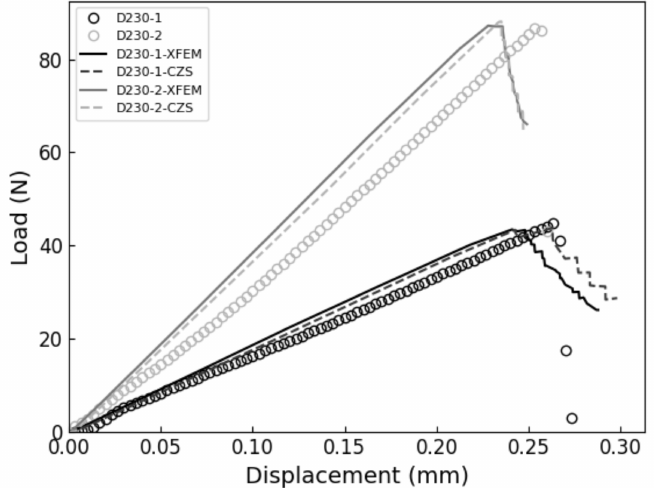
Figure 5. XFEM-predicted SENB test load-displacement curves (solid lines) benchmarked against experimental data for each nanocomposite resin.